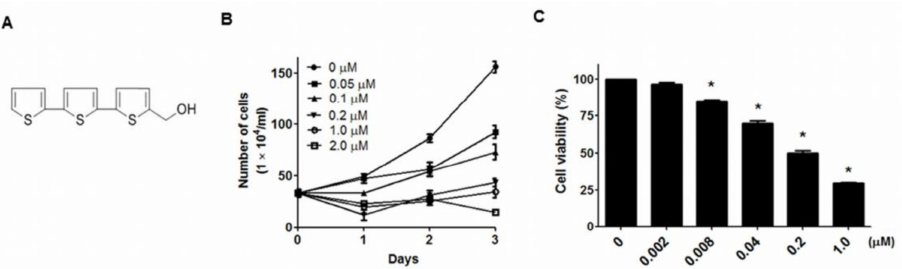
Figure 5. ( A ) The chemical structure of α -terthienylmethanol. ( B ) Exponentially growing OVCAR3 cells were treated with the indicated concentrations of α -terthienylmethanol for 3 days. ( • control; 0.05 µ M; (cid:78) , 0.1 µ M; (cid:72) , 0.2 µ M; (cid:7) , 1.0 µ M; (cid:3) , 2.0 µ M). Cells were loaded on a hemocytometer, and viable cell number was determined. ( C ) OVCAR3 cells were treated with indicated concentrations of α -terthienylmethanol and the cell viability was determined using MTT assay. * p < 0.05 versus the control group. Copyright (2017) Elsevier